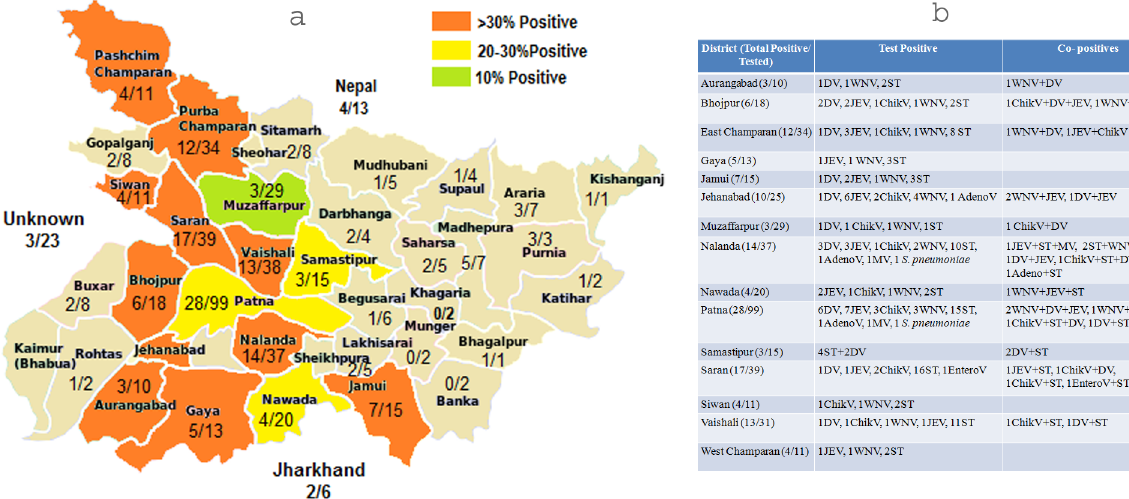
Fig 4. Geographic distribution of cases referred to the virology laboratory. 4a: Bihar district map showing number of cases positive for any test/ total cases referred from that district. 4b: Table showing district wise distribution of positives and co-positives in those referring more than 10 cases to the virology